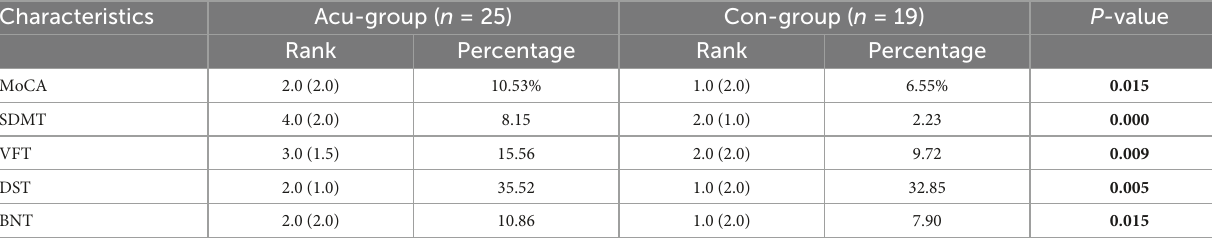
TABLE 3 Group differences before and after treatment.